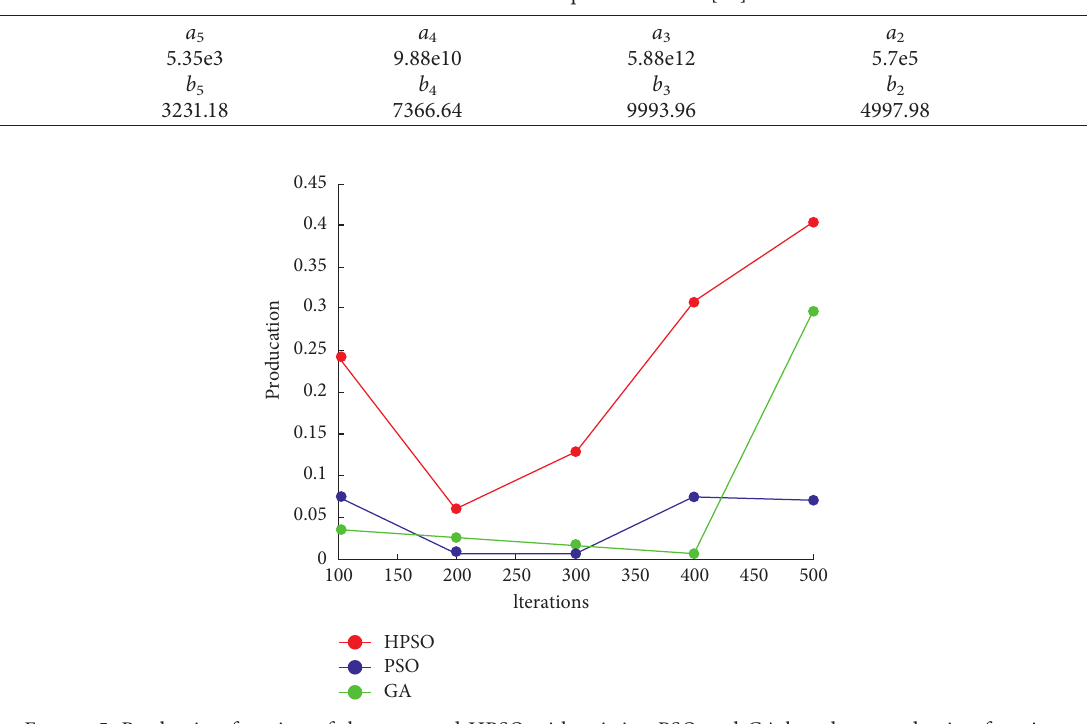
Table 1: Coefficient of equation in Ref. [23].